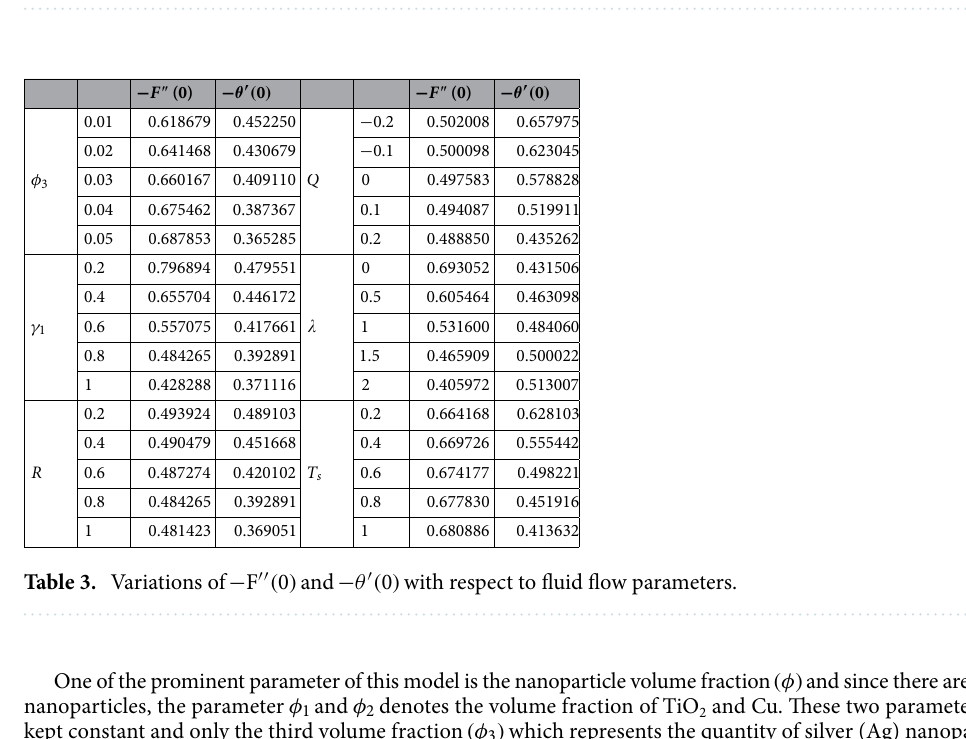
Figure 9. T s on θ(η) .